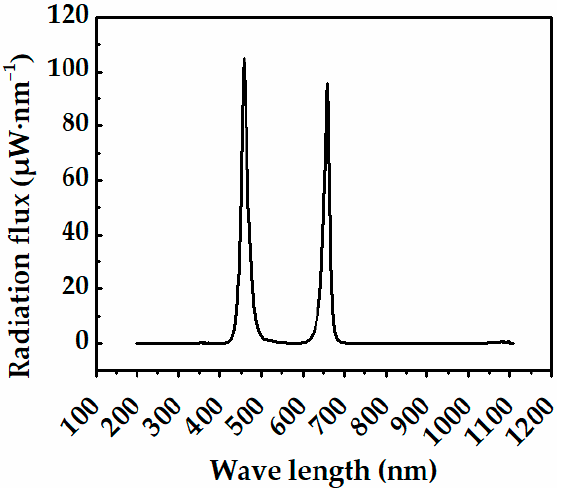
Figure 1. Spectral quality of 200 μ mol ∙ m − 2 ∙ s − 1 from SS LEDs with light ratios (%) of red/blue 50:50. Table 1. Illumination parameters of different treatments in Exp. 1. Treatments